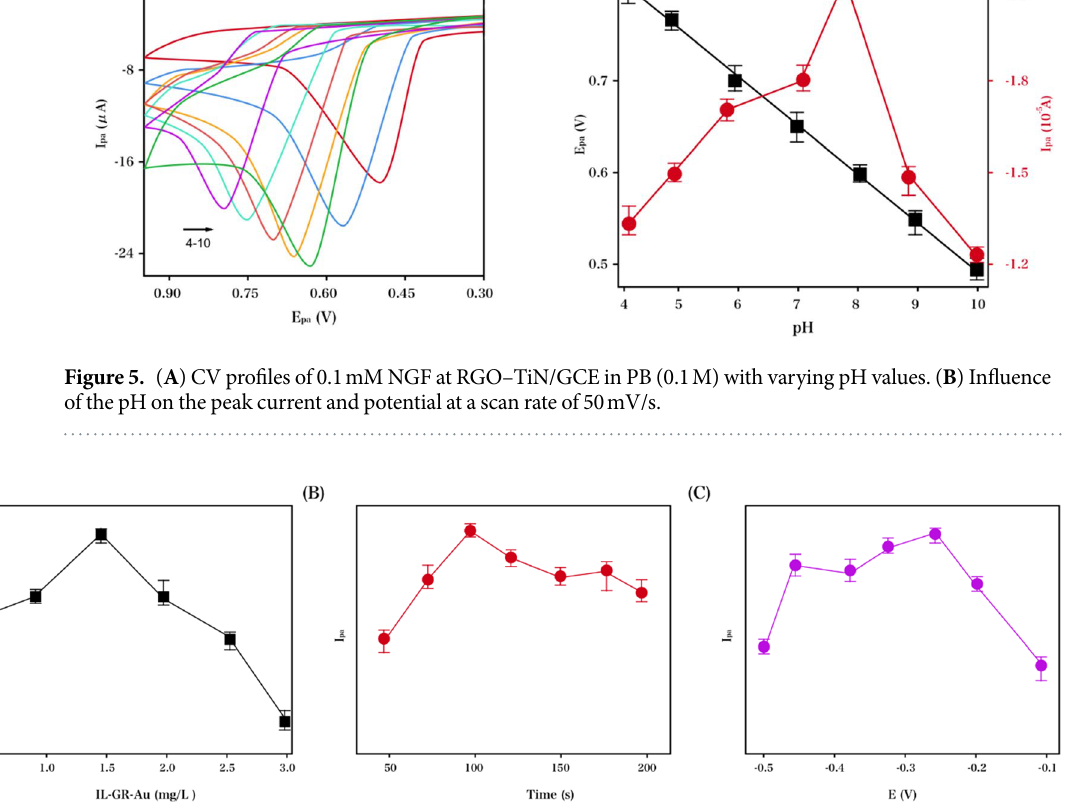
Figure 6. Effects of ( A ) RGO–TiN content, ( B ) accumulation time and ( C ) accumulation potential on the oxidation peak current of NGF (0.1 mM) in PB (0.1 M) with a pH of